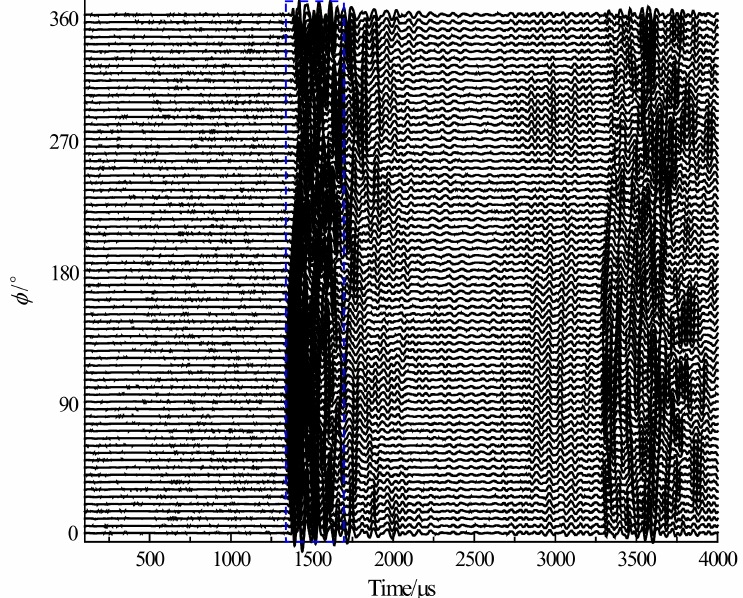
Figure 13. Time-domain waveforms of the sound pressure received by the hydrophone when a single piezoelectric vibrator